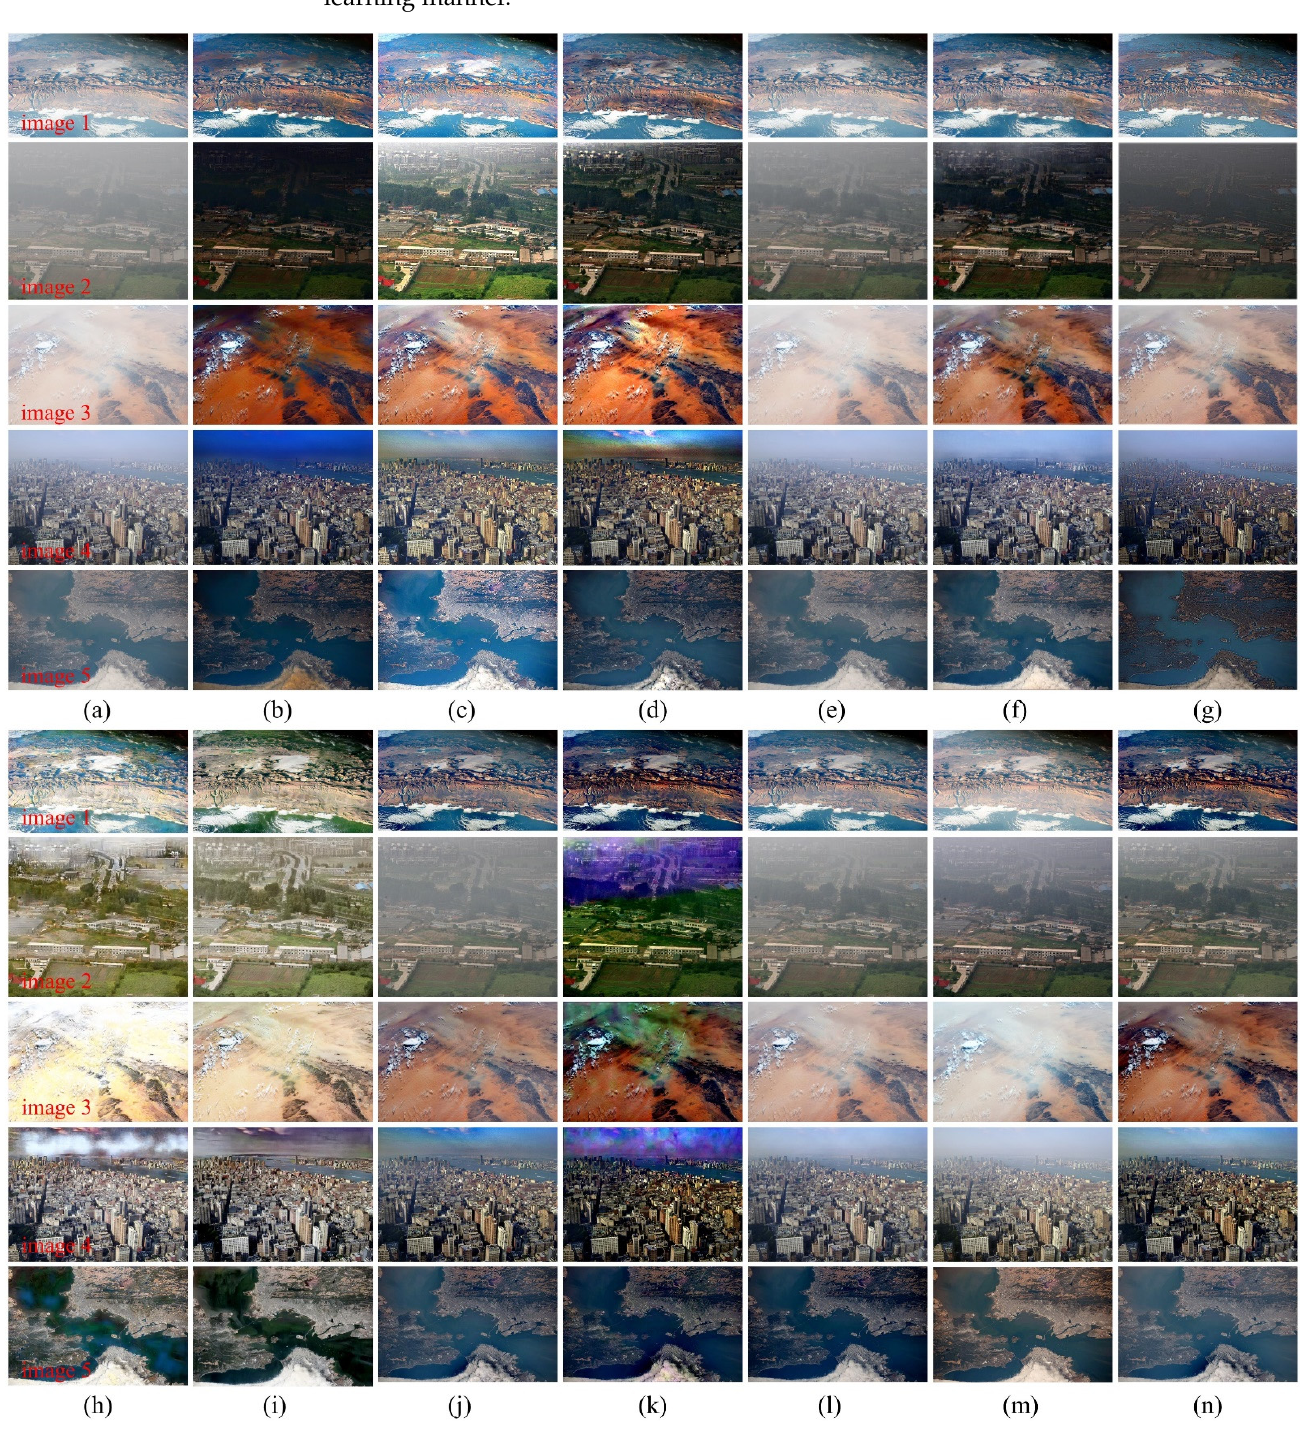
Figure 7. Comparisons with SOTA dehazing methods on real-world RS hazy images. ( a ) Hazy input image. ( b ) DCP. ( c ) MOF. ( d ) BCDP. ( e ) FFA. ( f ) EMRA. ( g ) LDN. ( h ) AESUN. ( i ) TBNN. ( j ) DDIP. ( k ) ZID. ( l ) YOLY. ( m ) ZIR. ( n ) Our method.